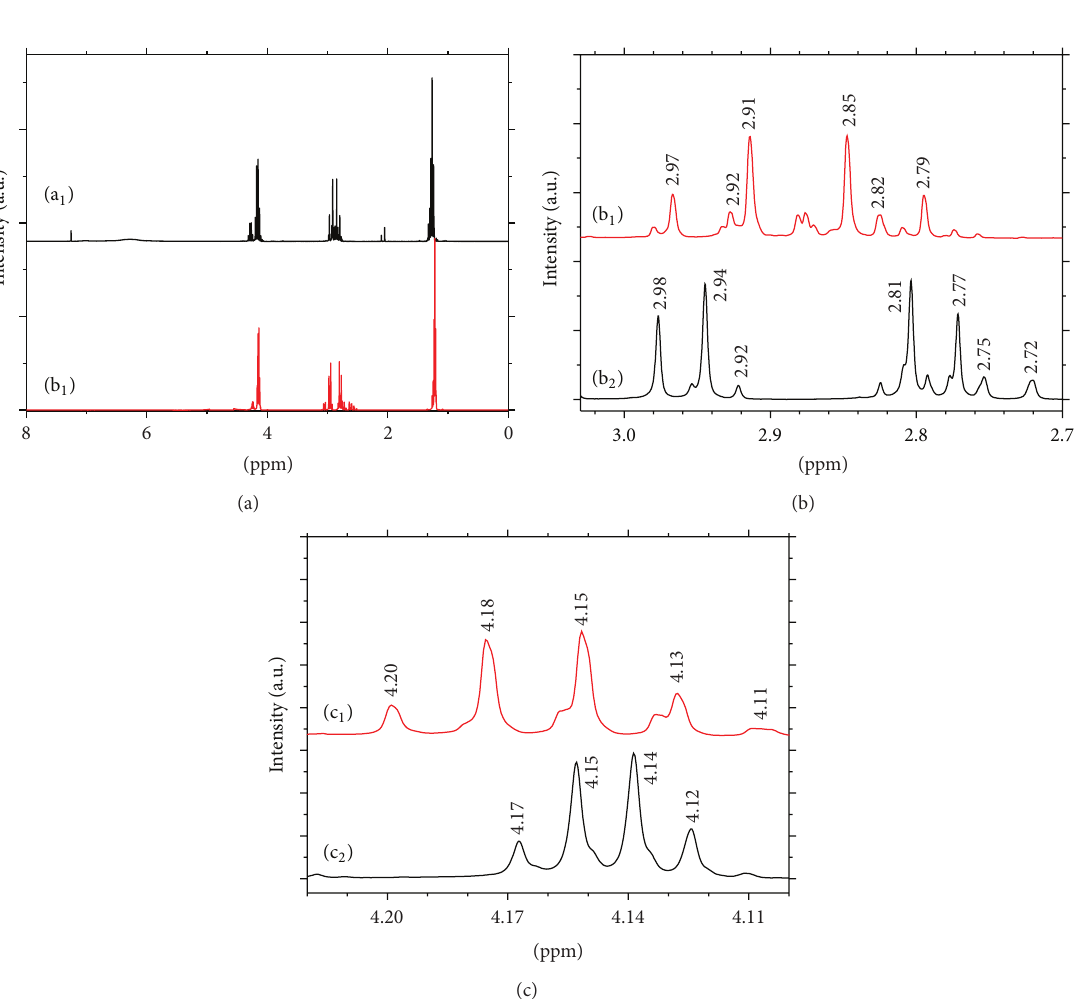
Figure 6: 1 H NMR spectra of Et 2 Cit and its complex CaEt 2 Cit. (a 1 , b 1 , and c 1 ) are Et 2 Cit; (a 2 , b 2 , and c 2 ) are CaEt 2 Cit. (a) Total spectra, (b) 𝛿 = 2.70 – 3.00 section, (c) 𝛿 = 4.10 – 4.21 section. and specificity of the two peaks of 2.70 ppm